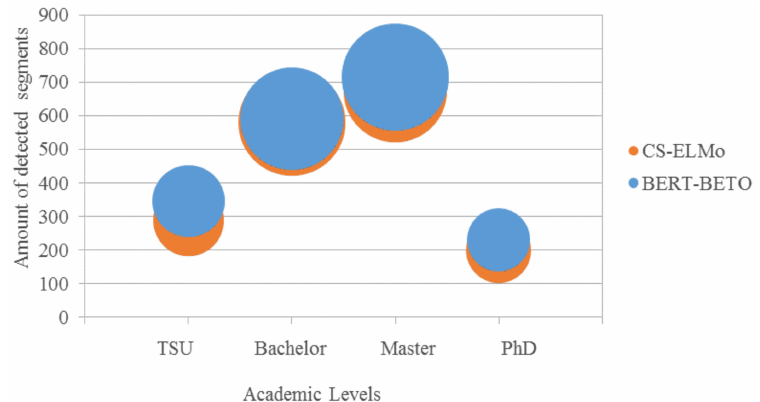
Figure 4. Amount of segments identified by the CS-ELMo and BERT-BETO